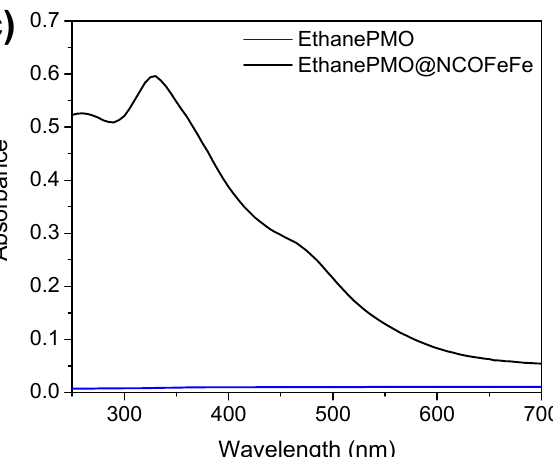
Figure 4. XRD patterns ( a ), FTIR-ATR spectra ( b ), and UV–VIS diffuse reflectance spectra ( c ) of EthanePMO and EthanePMO@NCOFeFe.